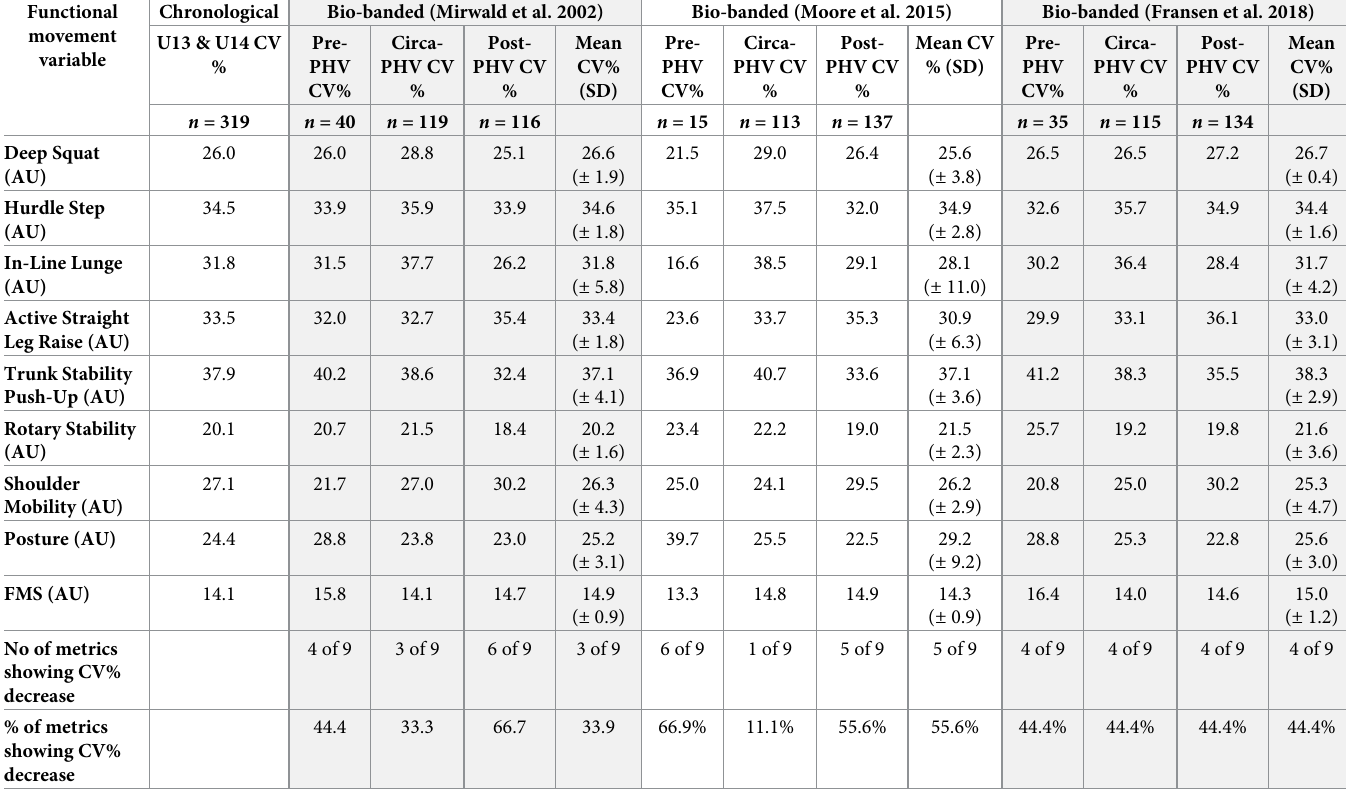
Table 4. Summary table of the coefficient of variance (CV%) for U13 and U14 academy soccer players functional movement characteristics when categorised using an aggregated chronological age group or three different Mirwald, Baxter-Jones [23], Fransen, Bush [24] and Moore, McKay [29] bio-banding (pre-PHV, circa- PHV and post-PHV) methods.